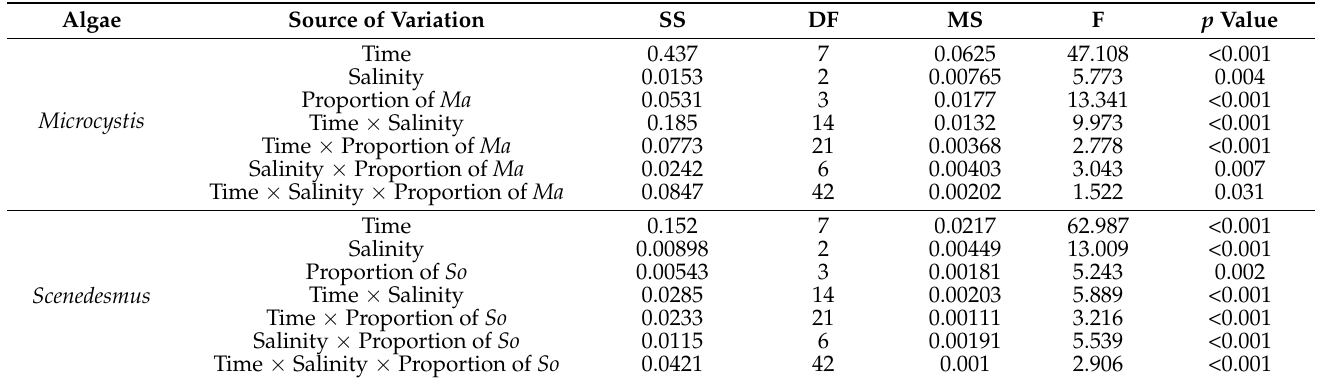
Figure 5. The maximal efficiency of PSII photochemistry ( F v / F m ) of M. aeruginosa and S. obliquus in monocultures and cocultures with different initial algal compositions at three salinities (0: ( a , d ), 3: ( b , e ), 6: ( c , f )) on different days. Table 3. Summary of three-way ANOVAs for the effects of salinity, proportion, and culture time on the maximal e ffi ciency of PSII photochemistry ( F v / F m ) of M. aeruginosa and S. obliquus .